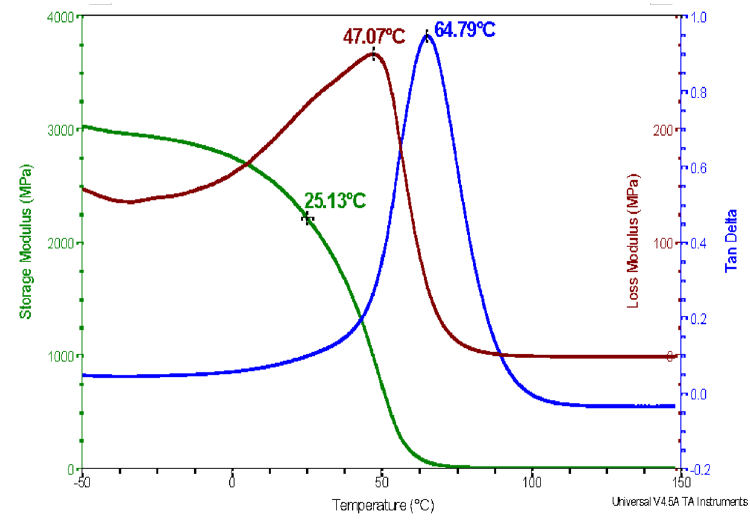
Figure 3. Thermal analysis curve of Polymer B obtained from single-frequency test.